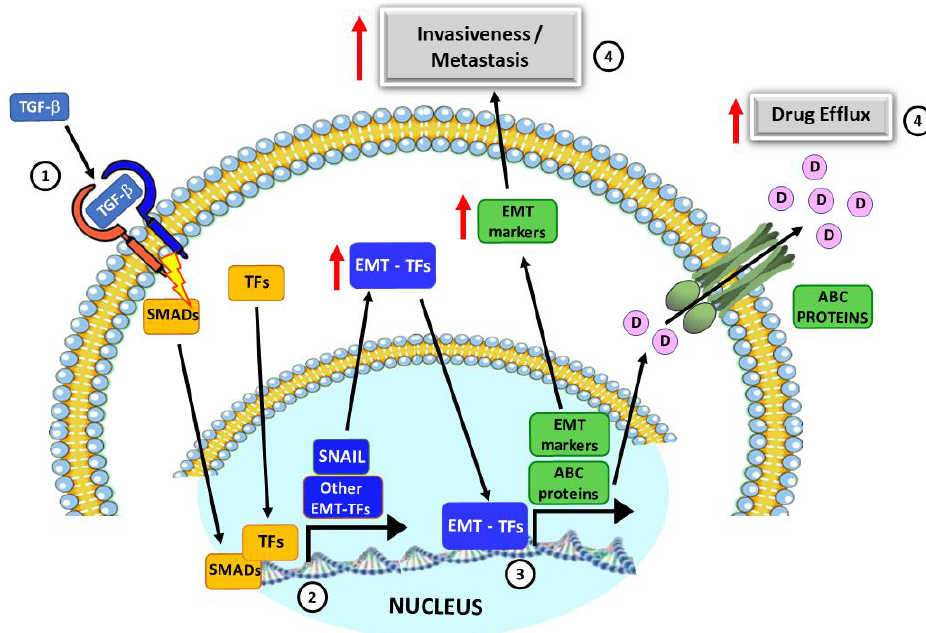
Figure 1. Cell signaling pathways triggered by TGF- β during epithelial mesenchymal transition (EMT) in cancer cells. (1) TGF- β binding to its receptor induces the activation of SMAD proteins in the cytosol, which are translocated into the nucleus together with other transcription factors (TFs), activated by other stimuli. (2) SMADs and other TFs promote the transcription of SNAIL and other EMT-transcription factors (EMT-TFs) that accumulate in the cytosol and are further translocated to the nucleus leading to the transcription of several mesenchymal-specific genes, or EMT markers (e.g., fibronectin and N-cadherin) and ABC transports (ABCB1, ABCC1 and ABCG2). (3) Enhanced expression of EMT markers leads to the onset of a mesenchymal phenotype, which present increased motility and invasiveness, including to distant sites (metastasis). (4) Enhanced ABC protein expression leads to increased extrusion of either drugs or other toxic compounds, leading to multi- drug resistance.